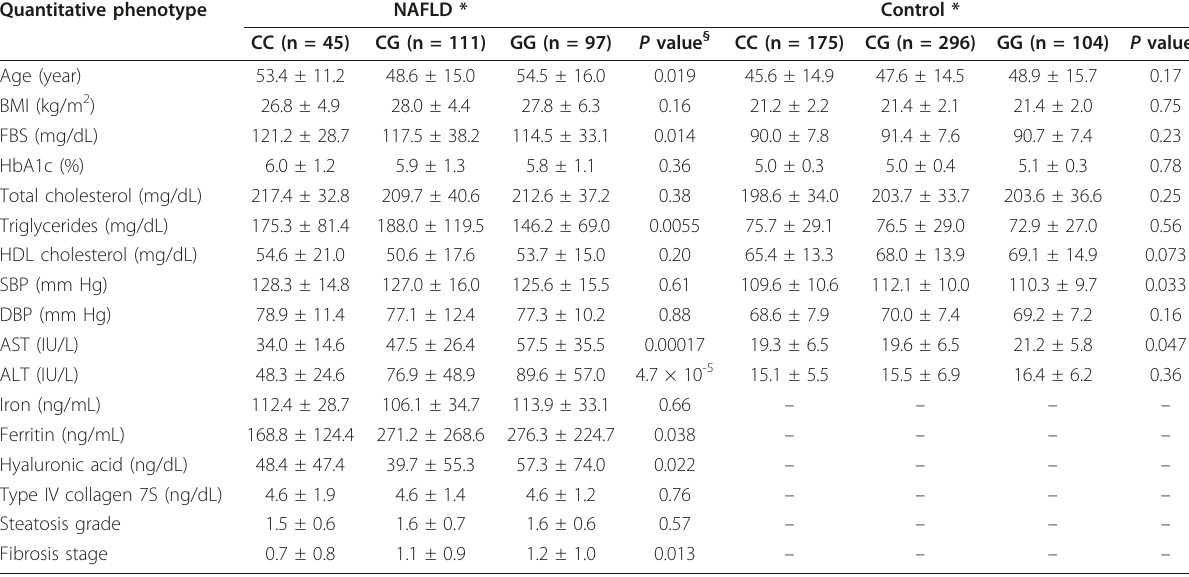
Table 4 Comparison of various quantitative phenotypes among the different genotypes at rs738409 in PNPLA3 in patients with NAFLD and control